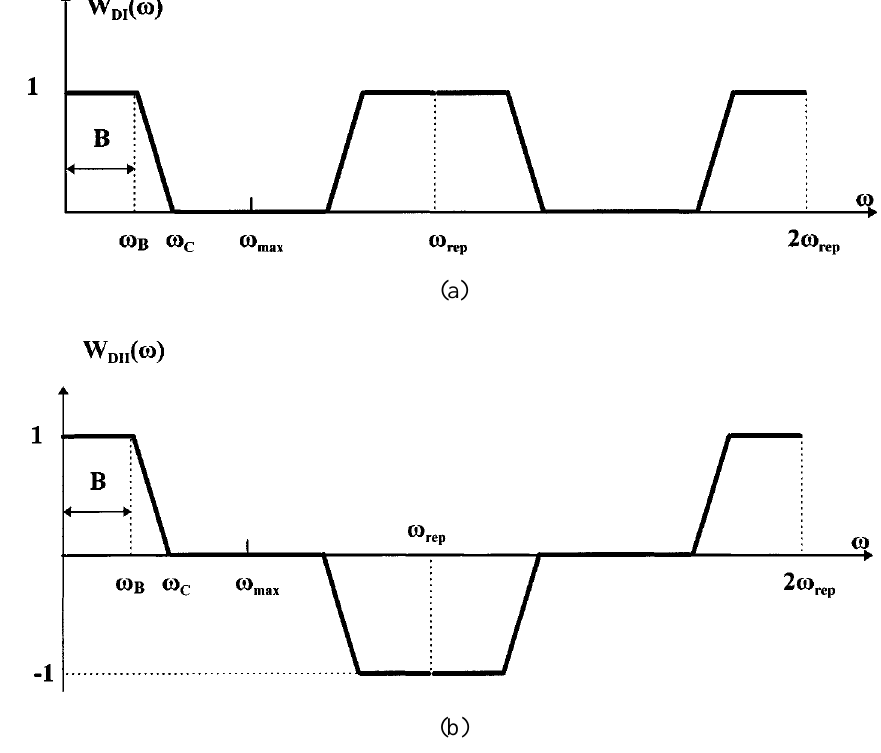
Fig. 1. Ideal behavior of a residual vibration error function. (a) Case I, (b) Case